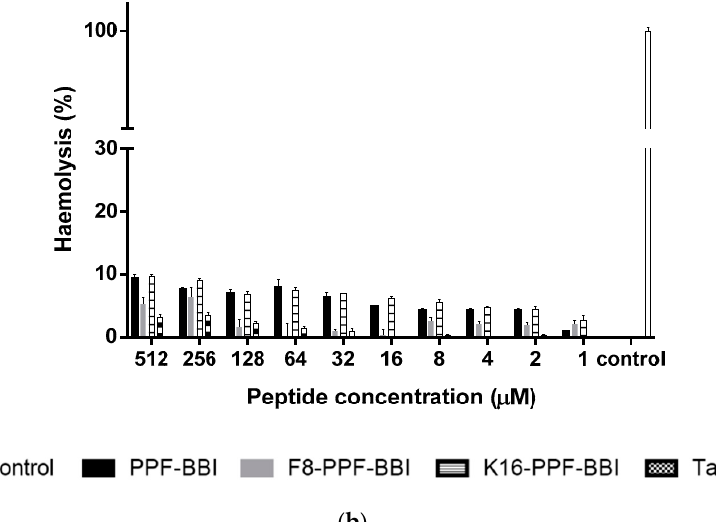
Figure 4. ( a ) The cell viability of the cancer cell lines H460, H157, H23, H838, HT-29, PC-3, U251MG and HMEC-1 at 4 mM 5-FU (stripe bar), 100 µM and 10 µM PPF-BBI, F 8 -PPF-BBI, K 16 -PPF-BBI and Tat-loop. The control represents the cell viability without any treatments. The statistical significance of difference was analyzed by a one-way ANOVA (* p < 0.05, **** p < 0.0001). ( b ) The haemolysis rates of PPF-BBI, F 8 -PPF-BBI, K 16 -PPF-BBI and Tat-loop on erythrocytes after being incubated for 4 h. The incubation of erythrocytes with 2% ( v / v ) Triton X-100 was designated as a positive control (100% haemolysis).